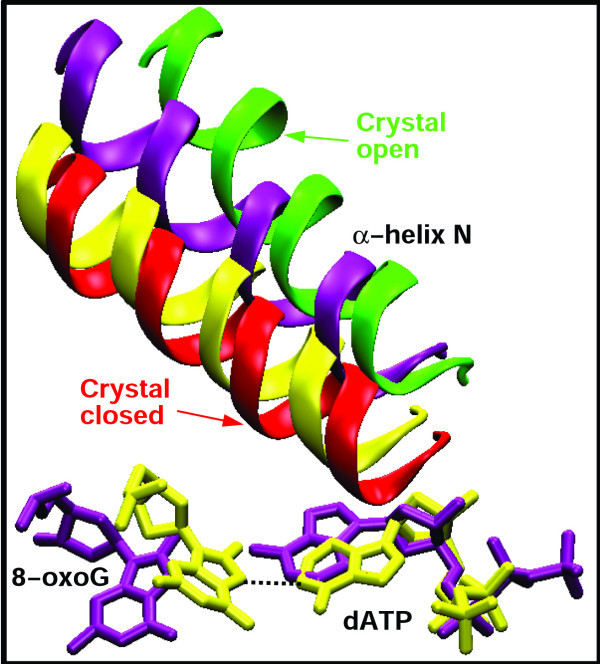
The α-helix N and the nascent base pair conformations in the wild-type and mutant 8-oxoG:dATP complexes. The final conformations of α-helices N and the nascent base pair in the wild-type (magenta) and Y271A mutant (yellow) pol β complex simulations with 8-oxoG:dATP are superimposed according to their palm subdmains and compared to the crystal open (green) and closed (red) structures.